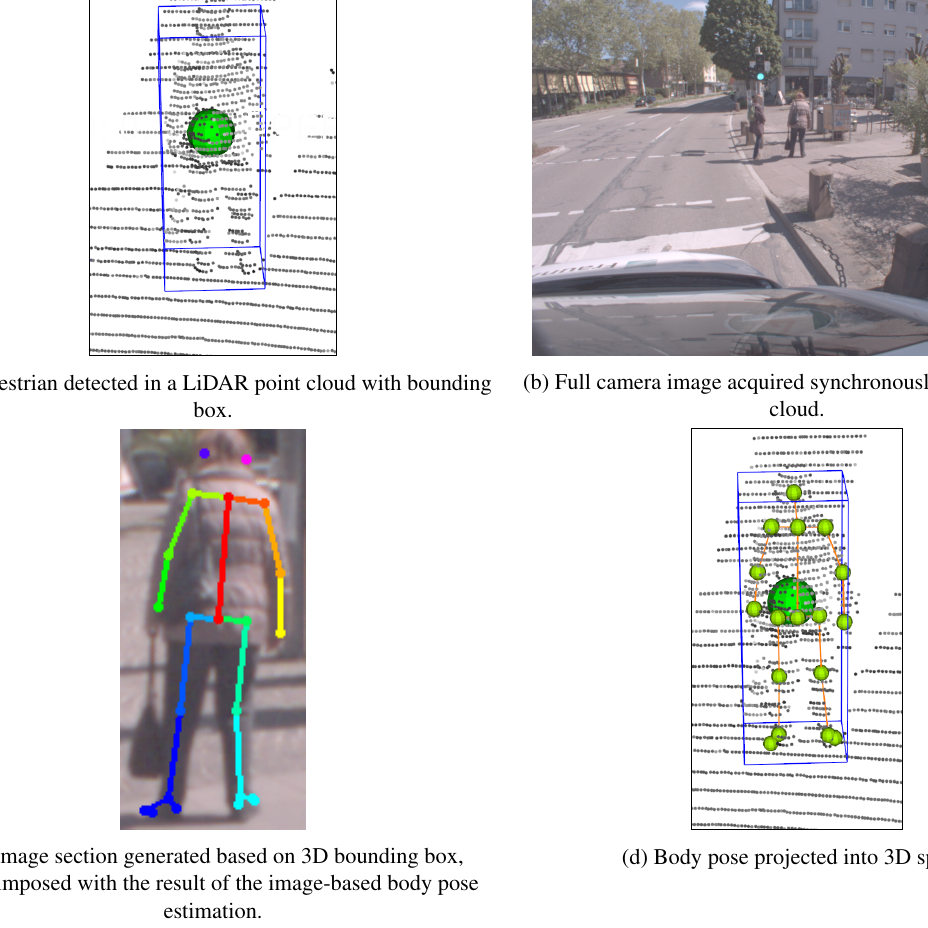
Figure 3. Processing steps for (a) and (b) image section generation based on detected pedestrians, (c) image based pose estimation, and (d) projection of the poses back to 3D